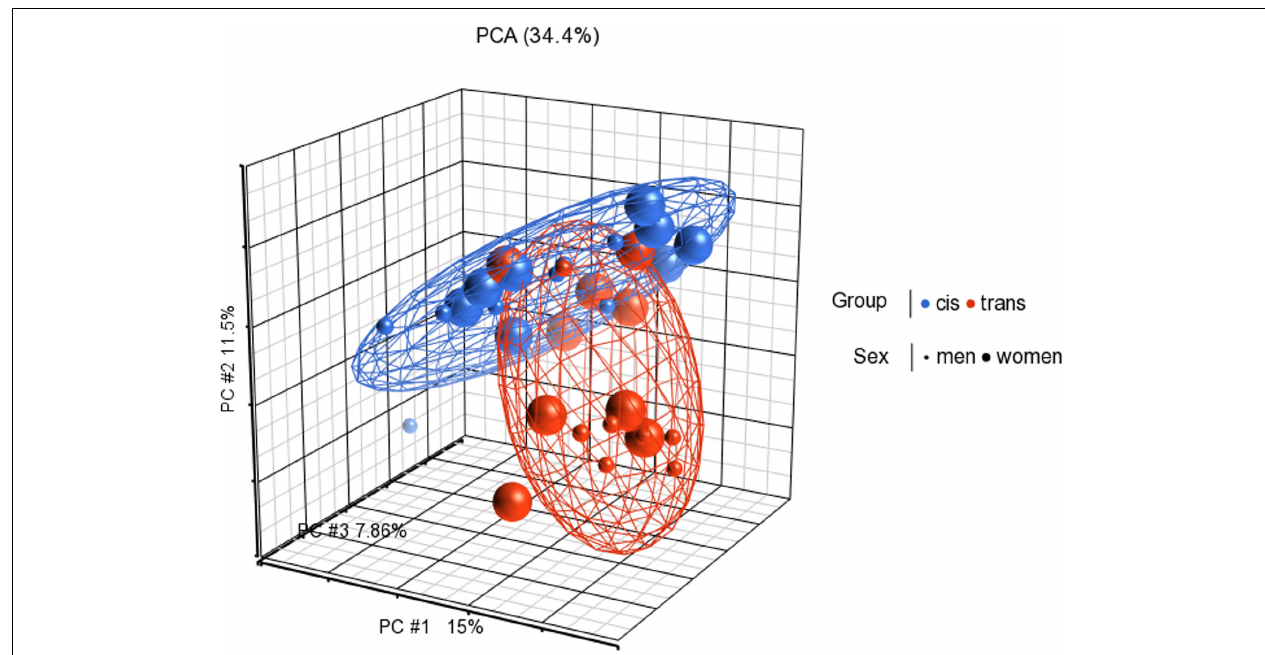
FIGURE 1 | Principal components analysis (PCA) in 3D showing methylation profiles of the study samples. Each sample is represented by a dot, the axes are the first three PCs, the percentages indicate the fraction of variance explained by each PC. The number at the top is the variance explained by the first three PCs. The samples are colored according to the levels of the variable “group” (blue for cisgender individuals and red for transgender individuals), and sized according to the levels of the variable “sex assigned at birth” (small for men and big for